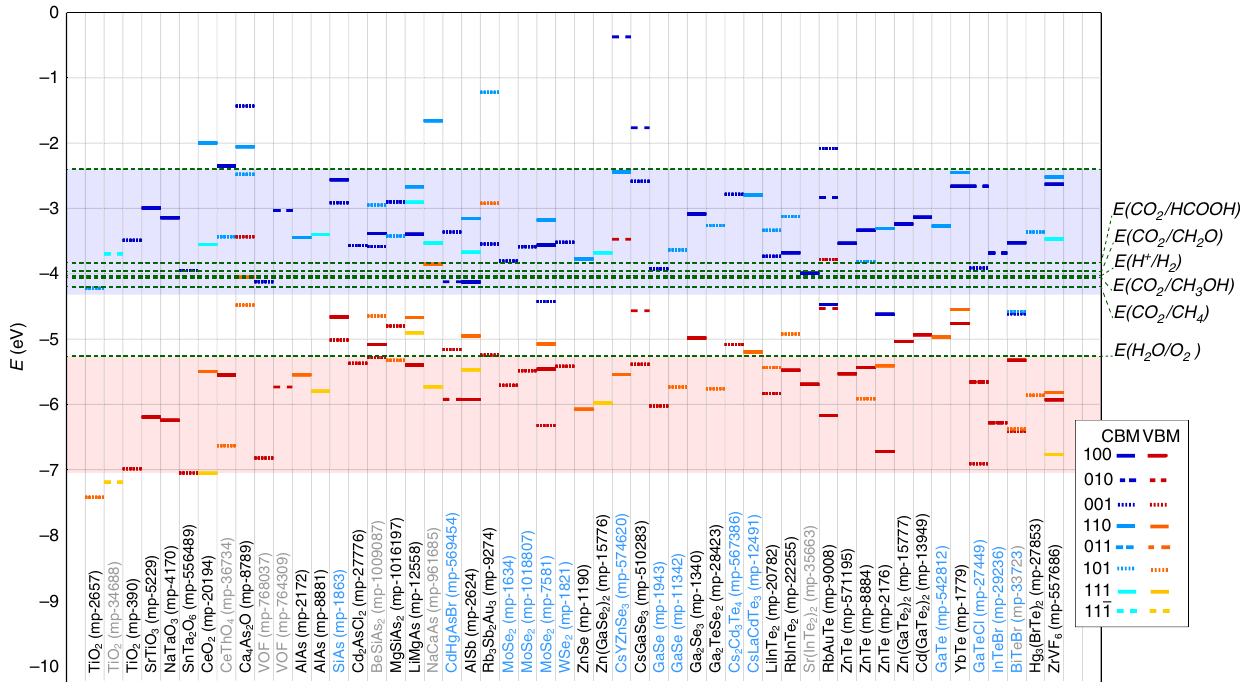
Fig. 3 Band-edge energies of materials which pass tier 6 are shown on the y -axis and the x -axis labels show the corresponding materials formula and the Materials Project material-id in parenthesis. The conduction band minima (CBM) of different planes are marked with lines in shades of blue and the valence band maxima (VBM) in the shades of red as shown in the fi gure legend. The energy levels E (CO 2 /HCOOH), E (CO 2 /HCHO), E (H + /H 2 ), E (CO 2 /CH 3 OH), E (CO 2 /CH 4 ), and E (H 2 O/O 2 ), in decreasing order of energy, are shown as green dashed lines. Note that all potentials are with respect to the vacuum level that is set to 0 eV. The blues shaded region shows the CBM which satisfy the criteria of tier 6. Materials which are reported in the Inorganic Crystal Structure Database (ICSD) are labeled in black, layered-materials are labeled in blue, and those which do not have a corresponding ICSD structure are labeled in gray. BiTeBr is labeled in blue and gray since it is a hypothetical layered material. The phonon spectra of the hypothetical materials are shown